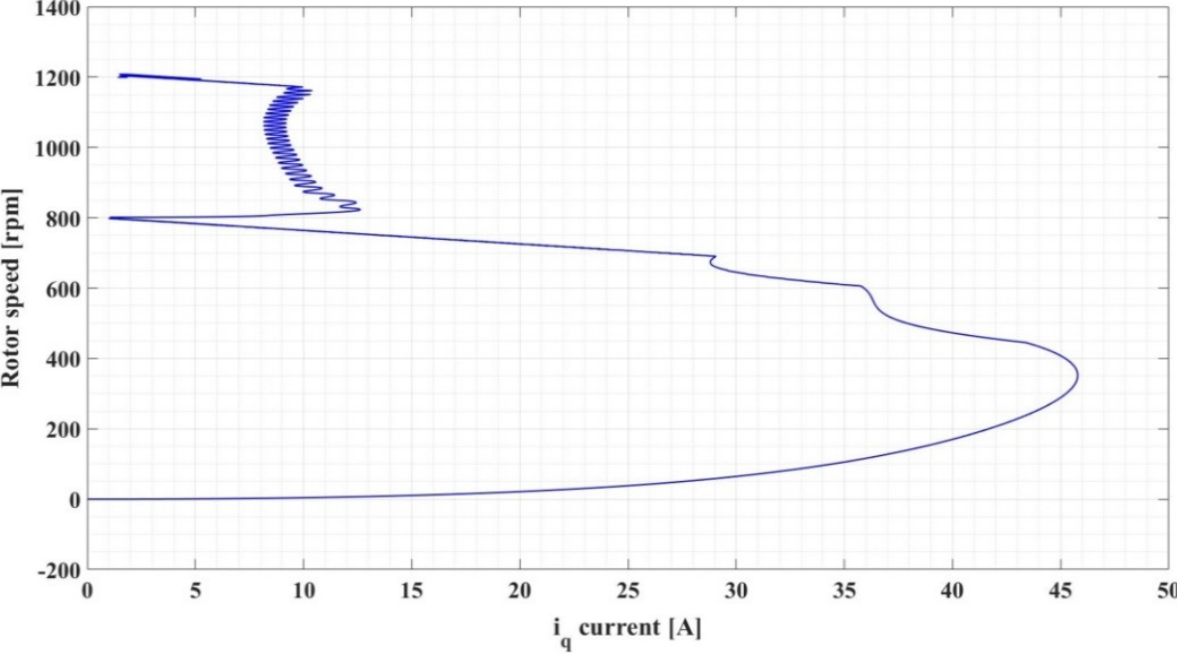
Figure 31. Image of the phase plan for PMSM variable structure with switching signal type 2: rotor speed versus i q current ( ω ref = [800, 1200] rpm).